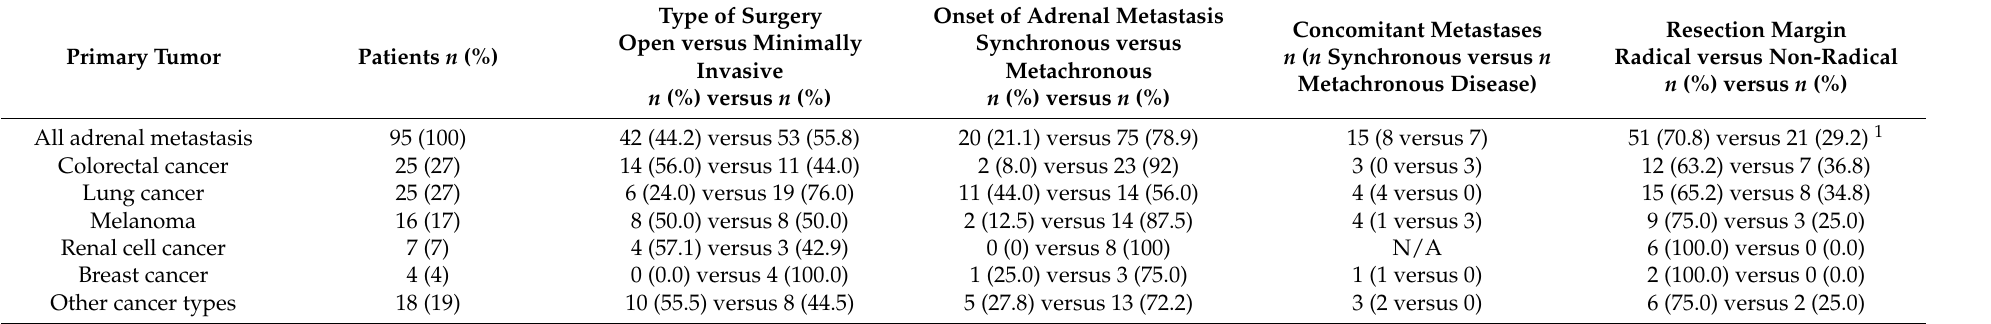
Table 1. Tumor type distribution. Type of surgery, the onset of adrenal metastasis, and resection margin per tumor type (number of patients and percentages).